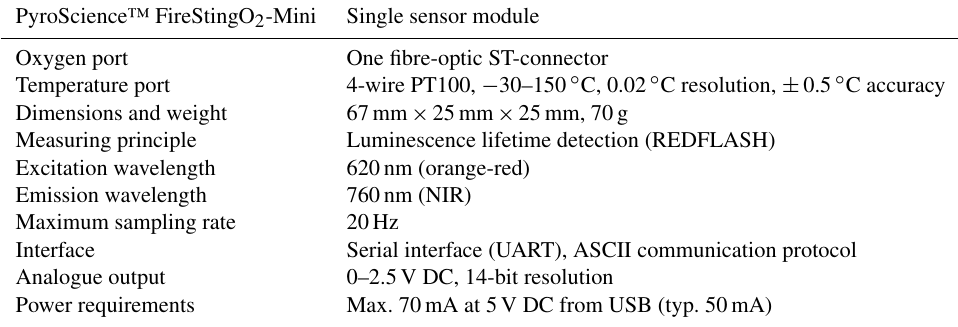
Table A2. Specifications of the PyroScience™ FireStingO 2 -Mini oxygen meter used in this study.